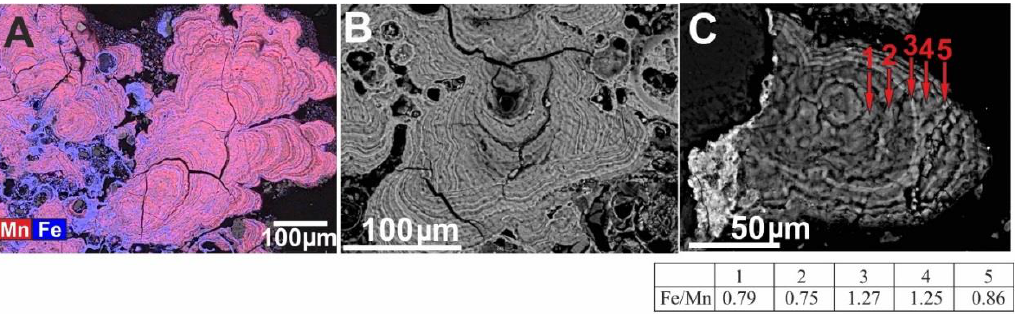
Figure 4. ( A ). Columnar and branching columnar structures, and ( B ). Colloform structures of ferromanganese minerals consisting of manganese and iron laminae. ( C ). Red arrows show locations of spot chemical results of Fe and Mn contents (inset table as ratios).